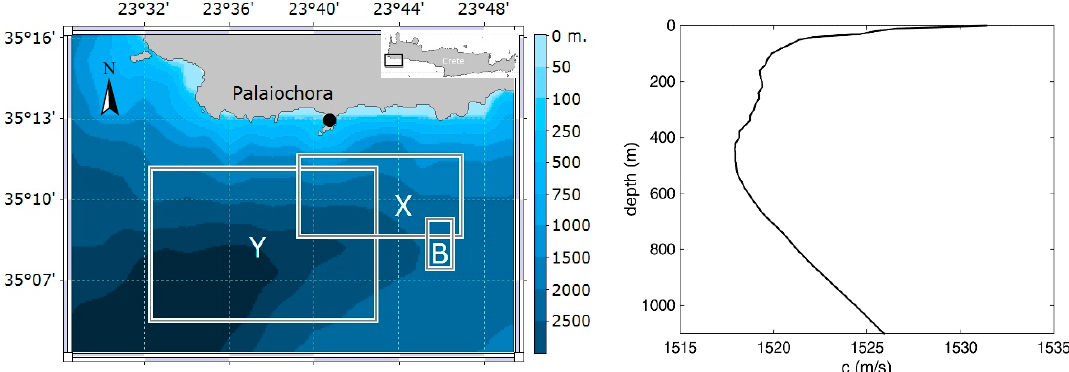
Figure 3. Area of the deep-water localization experiment off Palaiochora, southern Crete ( left ), and measured sound speed profile ( right ). The marked areas refer to the pinger localization experiment (B) and sperm whale X and Y localizations, respectively.